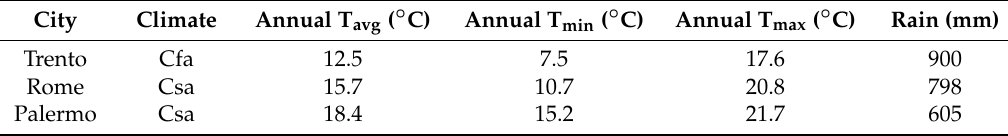
Table 3. Climate characteristics of the three locations selected for the